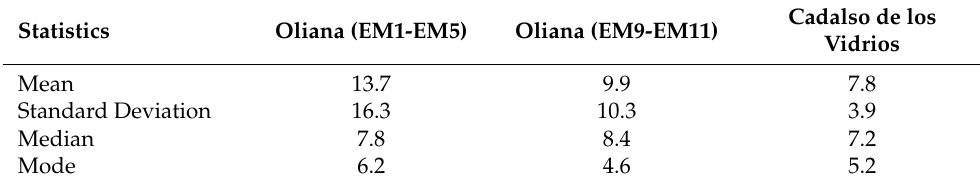
Table 2. Summary of effects of wildfires in the two studied climbing areas. Effects of Wildfires on Rock Surface Properties Oliana Cadalso de los Vidrios Discoloration low? moderate Extinction-related spalling low?